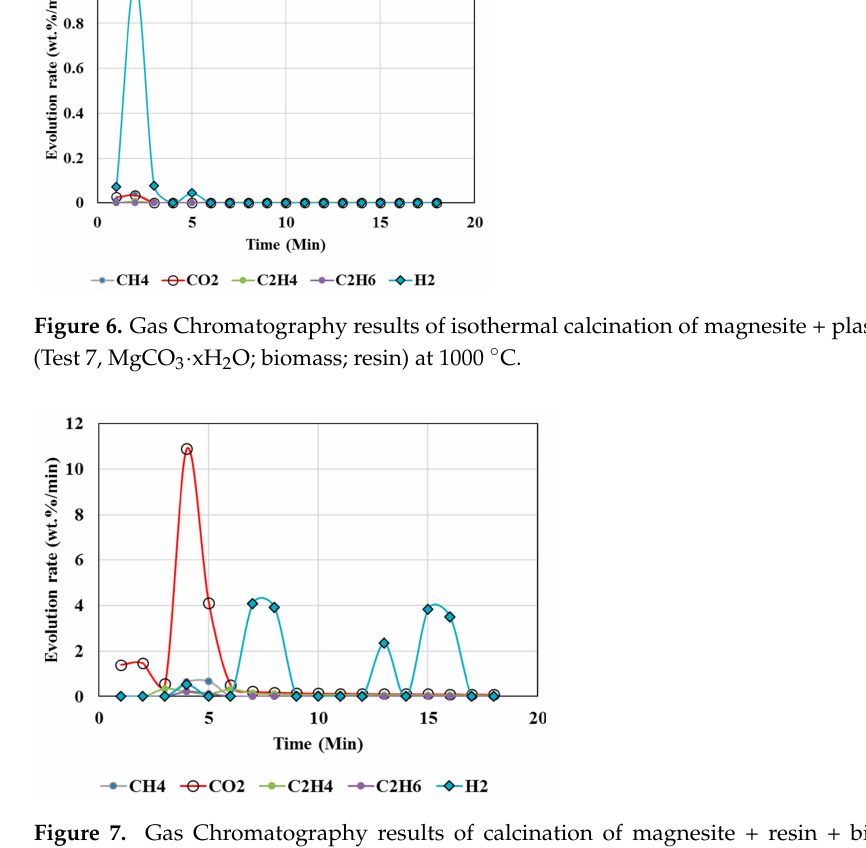
Figure 7. Gas Chromatography results of calcination of magnesite + resin + biomass (Test 8, MgCO 3 · H 2 O, biomass, resin) at 1000 ◦